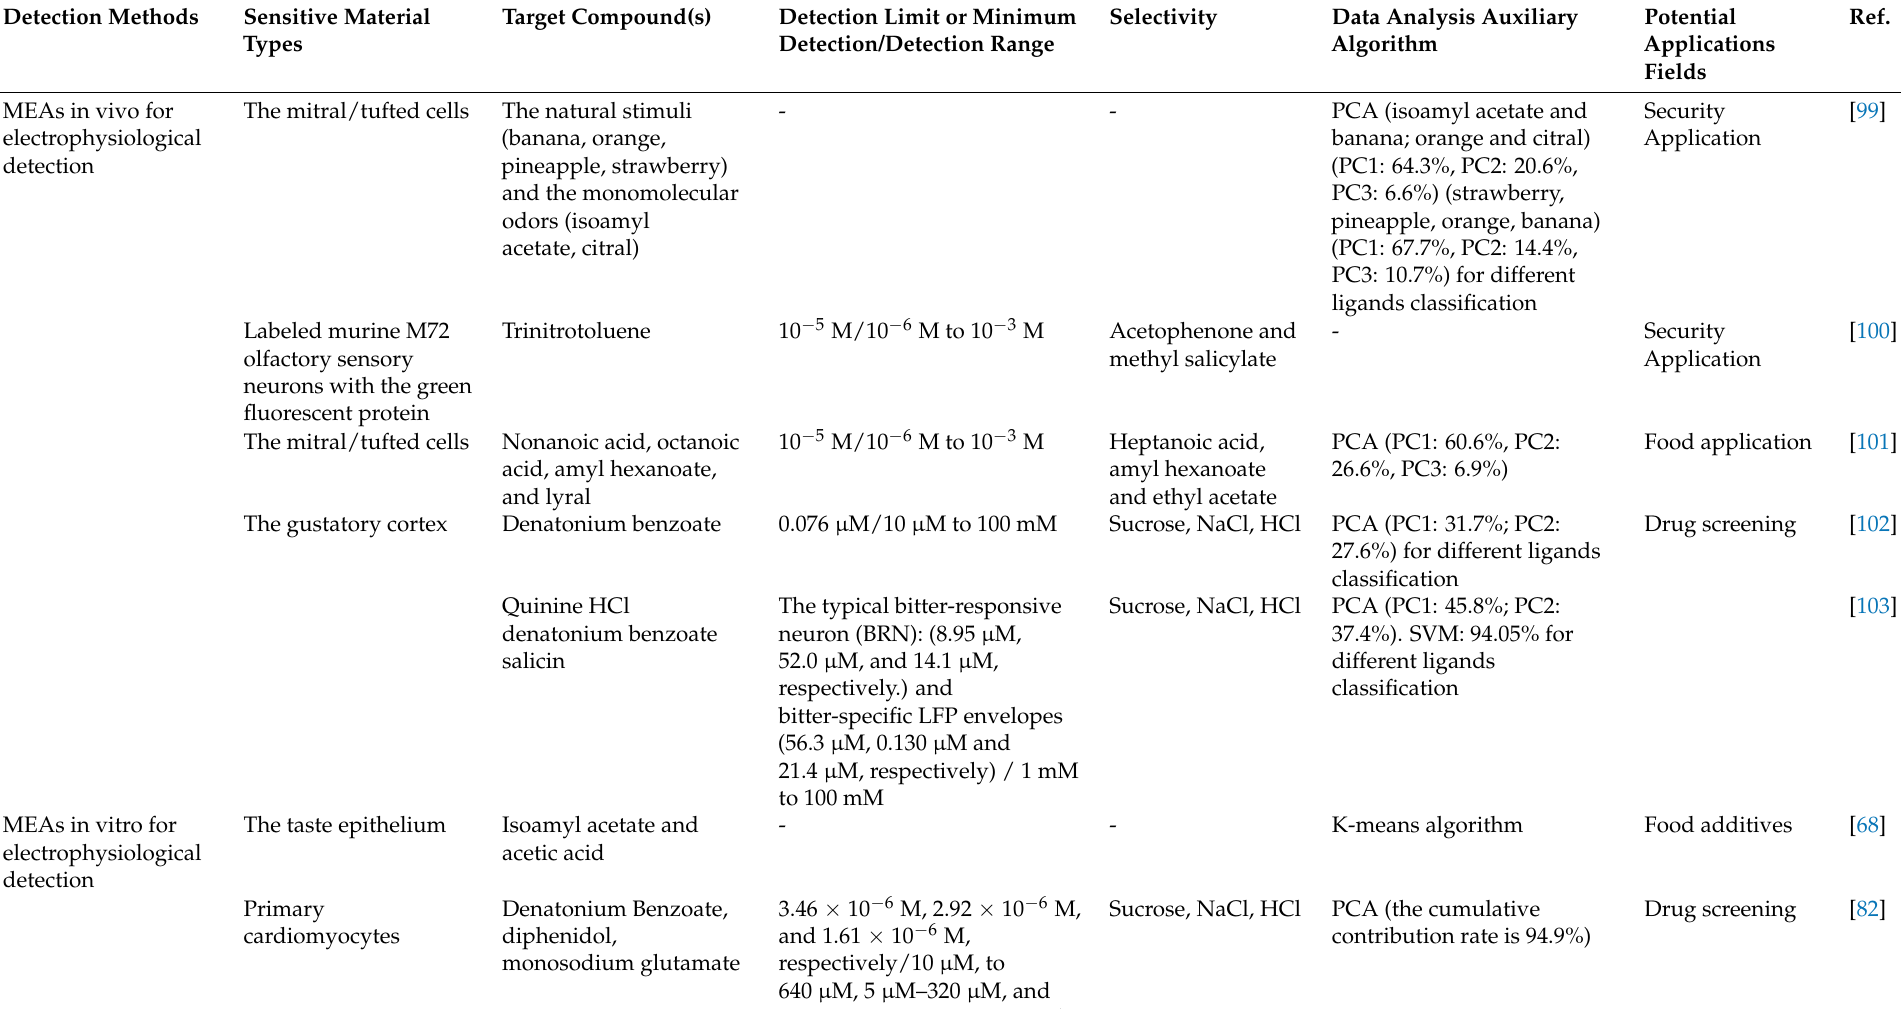
Table 2. Summary of detection strategies on biomimetic olfactory and gustatory biosensors based on electrode